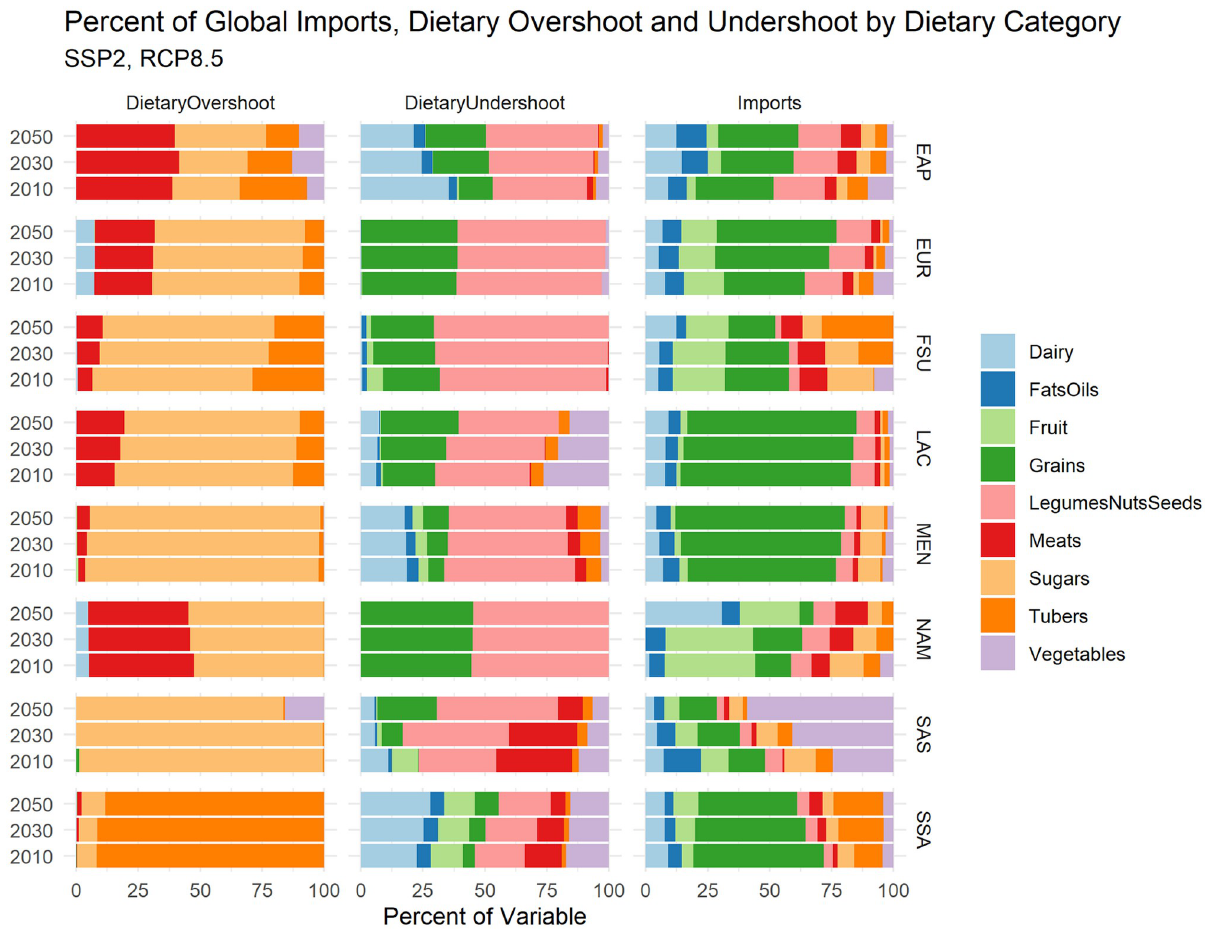
Fig 6. Regional percentages of dietary undershoot and overshoot represented by EAT-Lancet dietary category. Regional-level metrics are constructed as a population-weighted mean of country-level overshoot (left), undershoot (middle), and import volume (right). As the percent decomposition is a relative metric, the absolute size of any dietary category is not comparable across regions, but should be observed against other dietary categories across time for a given region.